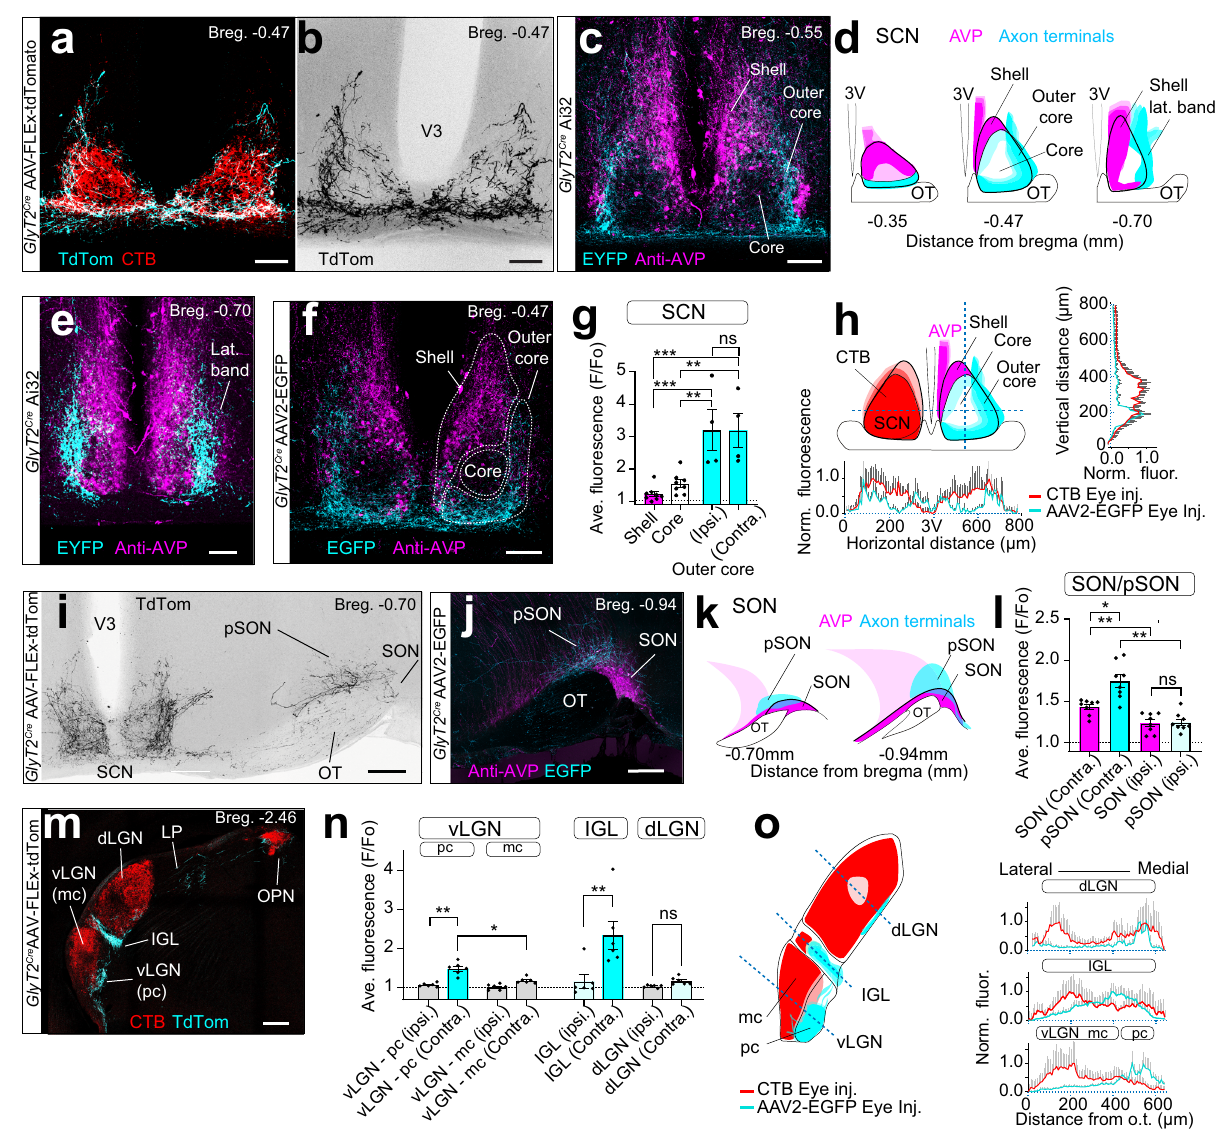
Fig. 5 | Axon projections to an SCN subregion and to the pSON. a , b Eye injec- tions of Cre -dependent AAV in the GlyT2 Cre mouse illustrating GlyT2Cre-ipRGC axons avoid the central core, which is stained by cholera toxin B (CTB). c Axons avoid the shell of the SCN localized by arginine vasopressin neurons. d Rostral (bregma − 0.35) to caudal (bregma − 0.70) distribution of axons. e Axons in the caudal SCN form a lateral band. f SCN, shell, core, and outer core regions used for fl uorescencequanti fi cationfollowing AAV2-FLEx-EGFP eyeinjections. g Normalized fl uorescence (F/Fo) of the SCN core and shell; bilateral (contralateral and ipsi- lateral),and SCNoutercoreforthe ipsilateraland contralateralSCN ( n =4animals, data were presented as mean values±SEM; ***top p =0.0004; ** top p =0.003; ***bottom p =0.0004; **bottom p =0.0028). h Illustration (left) and fl uorescence (rightandbelow)throughthehorizontalandventralaxisofSCN( AAV2-FLEx-EGFP ), n =6 animals, vs. CTB eye injections, ( n =2 animals). i Axons extend into lateral hypothalamic (LH) and anterior hypothalamic (AHC) areas, and there is a strong